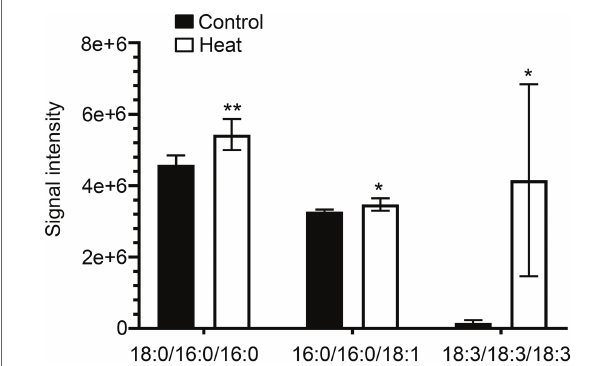
FIGURE 3 | Changes in the levels of triacylglycerol lipid molecular species in response to heat stress. Fully extended leaves detached from 173-d-old plants of B. grandis were at control condition (22 ° C for 2 h) or challenged with heat stress (45 ° C for 2 h). Three different molecular species of triacylglycerol (TG) including 18:0/16:0/16:0, 16:0/16:0/18:1, and 18:3/18:3/18:3 in leaves of B. grandis were shown. Values shown are mean ± SD ( n = 5). * p < 0.05, ** p < 0.01, two-sided Student’s t-